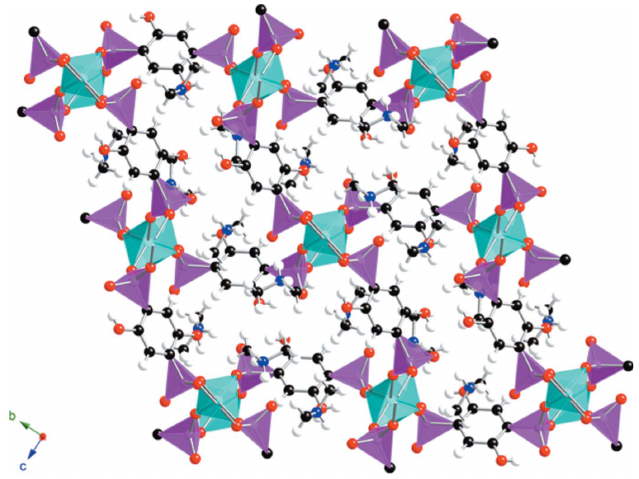
Figure 2 View down [100] of the three-dimensional framework structure of (I) with the ZnO 4 and PO 3 C moieties shown as polyhedra. Color key: ZnO 4 groups = cyan, PO 3 C groups = magenta, oxygen = red, carbon = black, hydrogen = white. The (CH 3 ) 2 NH 2+ cations are omitted for clarity.